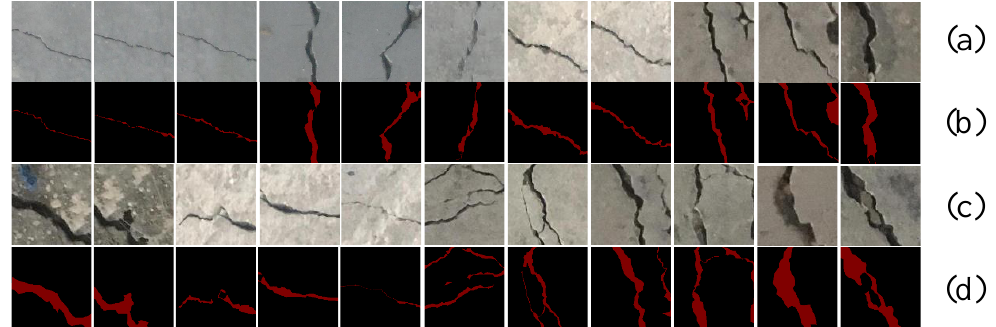
Figure 4. CCIC dataset: ( a , c ) original positive; ( b , d ) ground